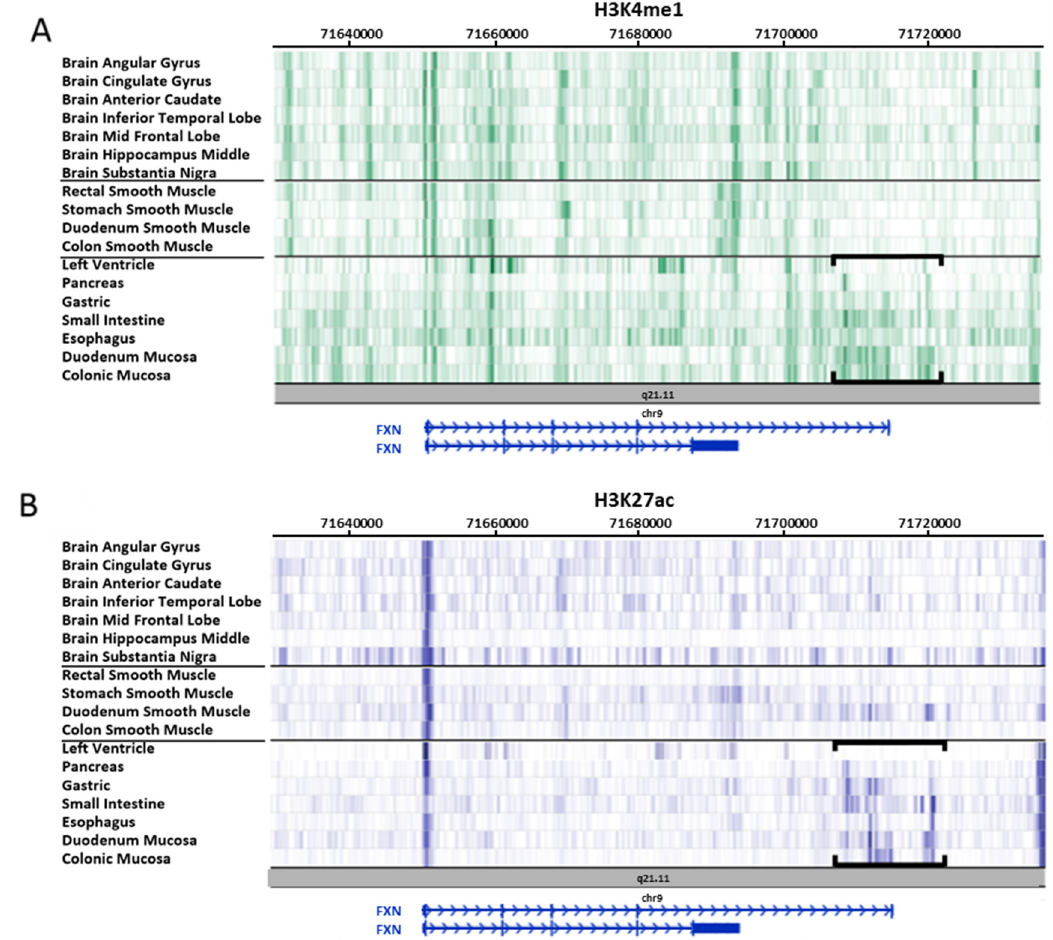
Figure 4. Epigenetic marks of enhancer regions in tissues provided by Roadmap. All data were collected from the Roadmap database [47] and visualized in its own browser (https: // epigenomegateway.wustl.edu / browser / roadmap). ( A ) H3K4me1 mark is related to enhancer regions; ( B ) H3K27ac mark is associated with strong enhancers. Tissues are organized in three groups: brain, muscle, and other tissues. Both marks (H3K4me1 and H3K27ac) show tissue-specific patterns, highlighting the region between the 3’end zone of intron 4 and the downstream region closest to the FXN gene, where H3K4me1 and H3K27ac signals are almost inexistent in muscle and brain tissues, whereas the remaining tissues present high intensity (region in brackets). Table 2. Intensity of the H3K4me1 epigenetic mark across the studied region: “weak” (<7.5; white), “intermediate” (7.5–10; light grey) or “strong” signal (> 10; dark grey). Abbreviations: Down, Downstream region; Ix, Intron x; ORF, Open Reading Frame; Up, Upstream region.